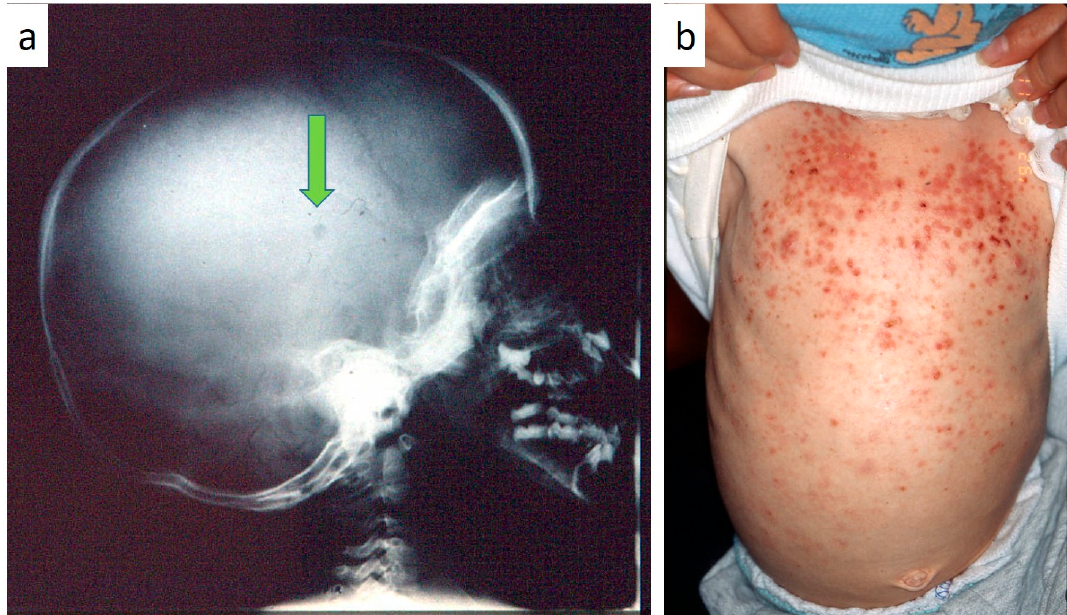
Figure 6. ( a , b ): Skull radiogram showing a small osteolytic lesion of the parietal bone ( a ); cutaneous rush occurring in children affected by LCH.